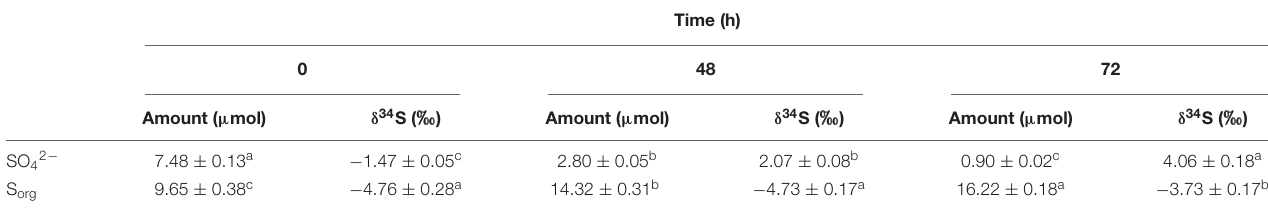
TABLE 1 | Amount and sulfur (S) isotope composition of the overall SO 42 − and S organic (Sorg) pools of rice plants grown in the absence of SO 42 − in the hydroponic